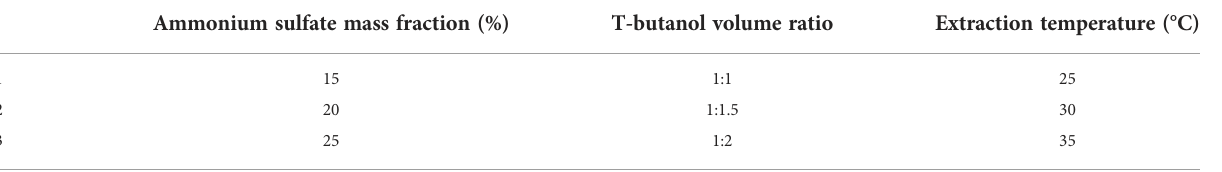
TABLE 2 Orthogonal test factor level